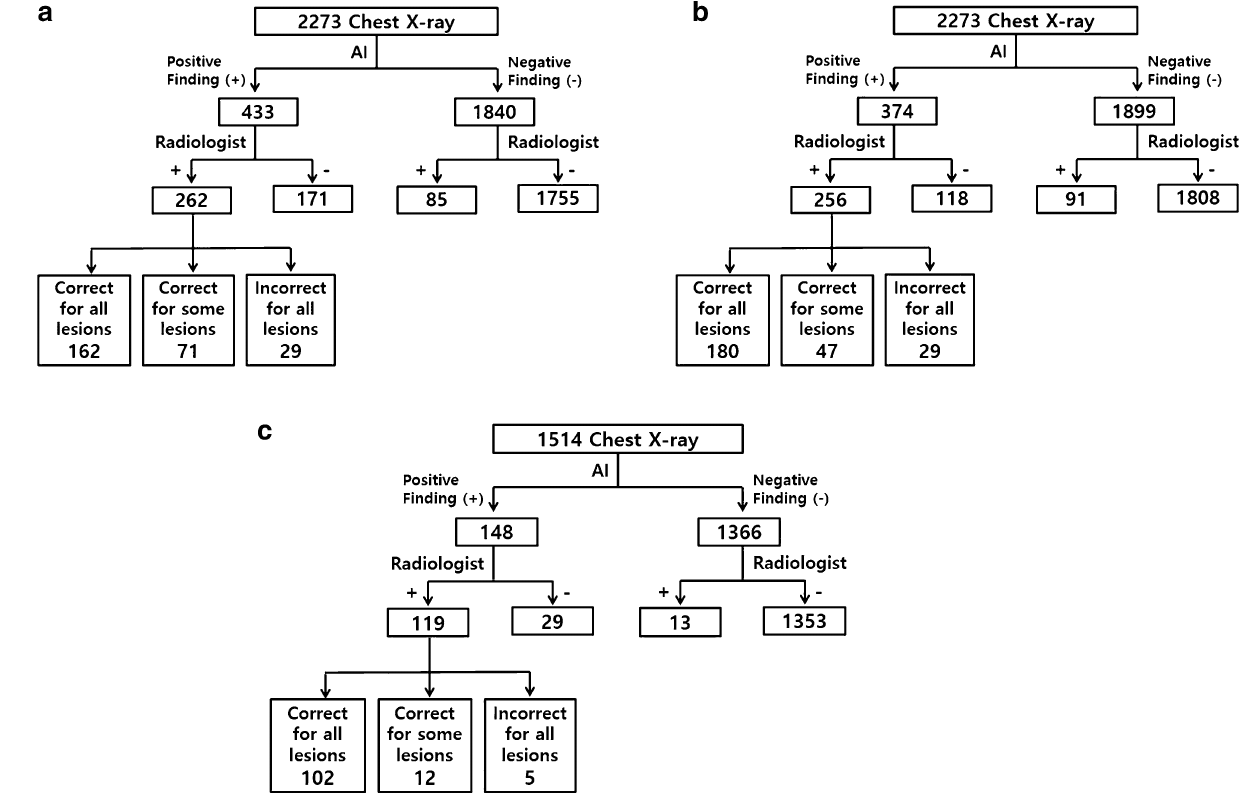
Figure 1. Flowcharts of diagnosis including ( a ) all lesions, ( b ) excluding cardiomegaly from all lesions, and ( c ) excluding cardiomegaly and patients ≤ 2 years